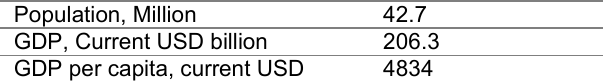
Table 1. Economic indicators for 2019